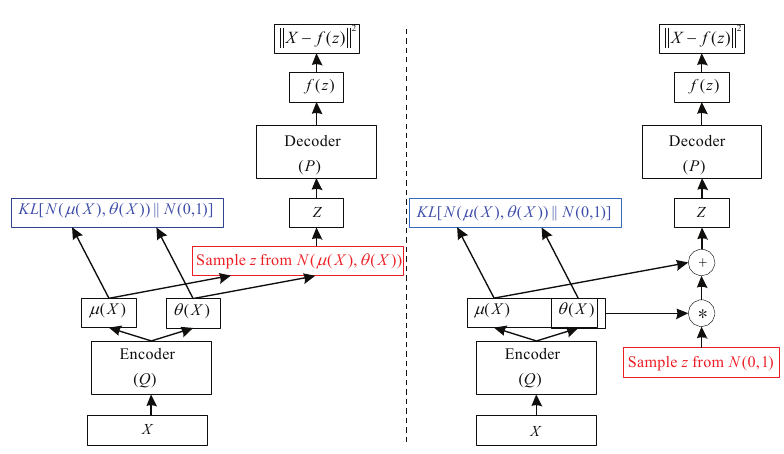
Figure 4. A training-time variational autoencoder implemented as a feedforward neural network. ( Left ) is without the “reparameterization trick”, and ( right ) is with it